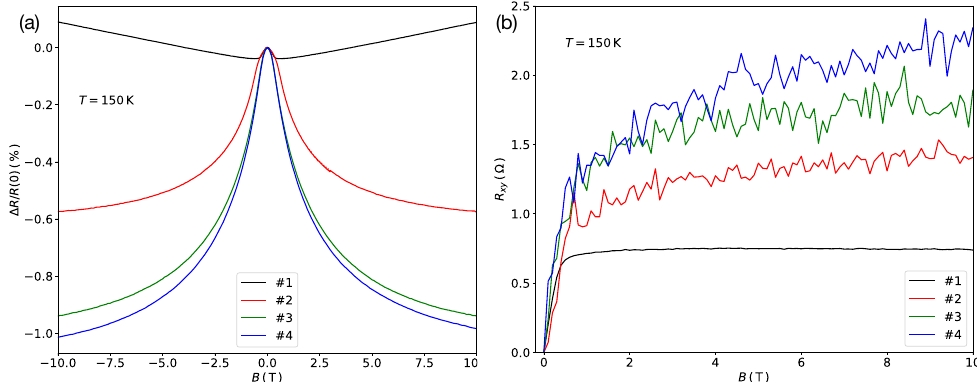
Figure 2. ( a ) Transversal magneto-resistance and ( b ) Hall resistance of samples #1 to #4. Data taken at 150K under dc current conditions ( I = 5 µ A). B = µ 0 H , with H being the applied magnetic